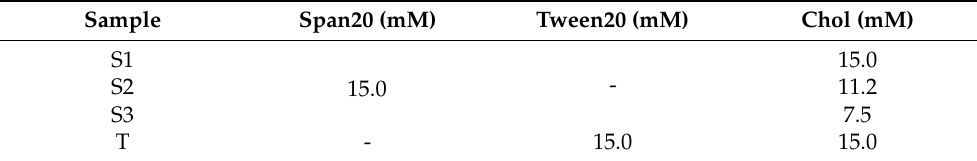
Table 4. Sample compositions.